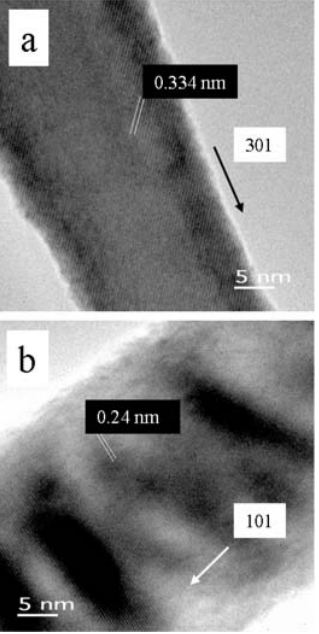
Figure 5. HRTEM image of (a) a single-crystal SnO nanowire, VS single-crystal SnO 2